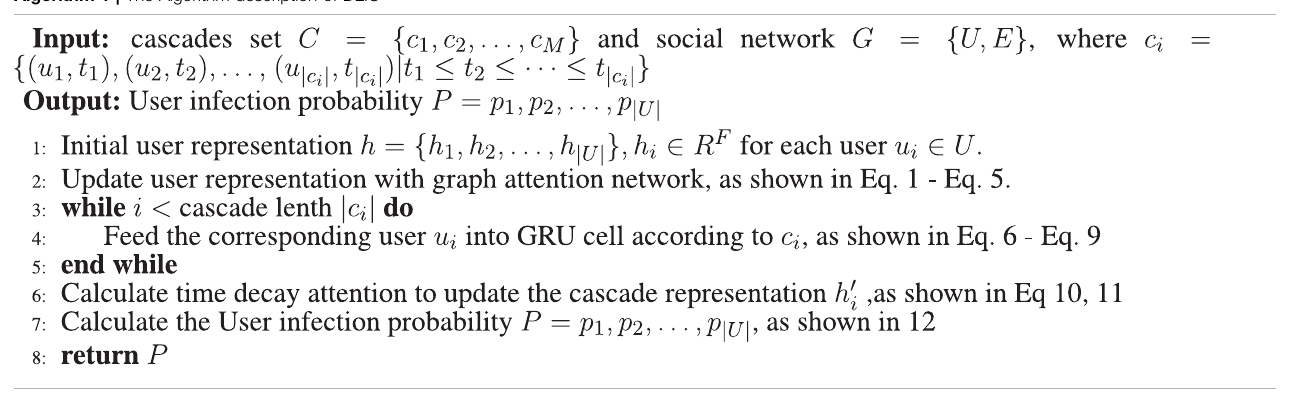
Algorithm 1 | The Algorithm description of DLIC